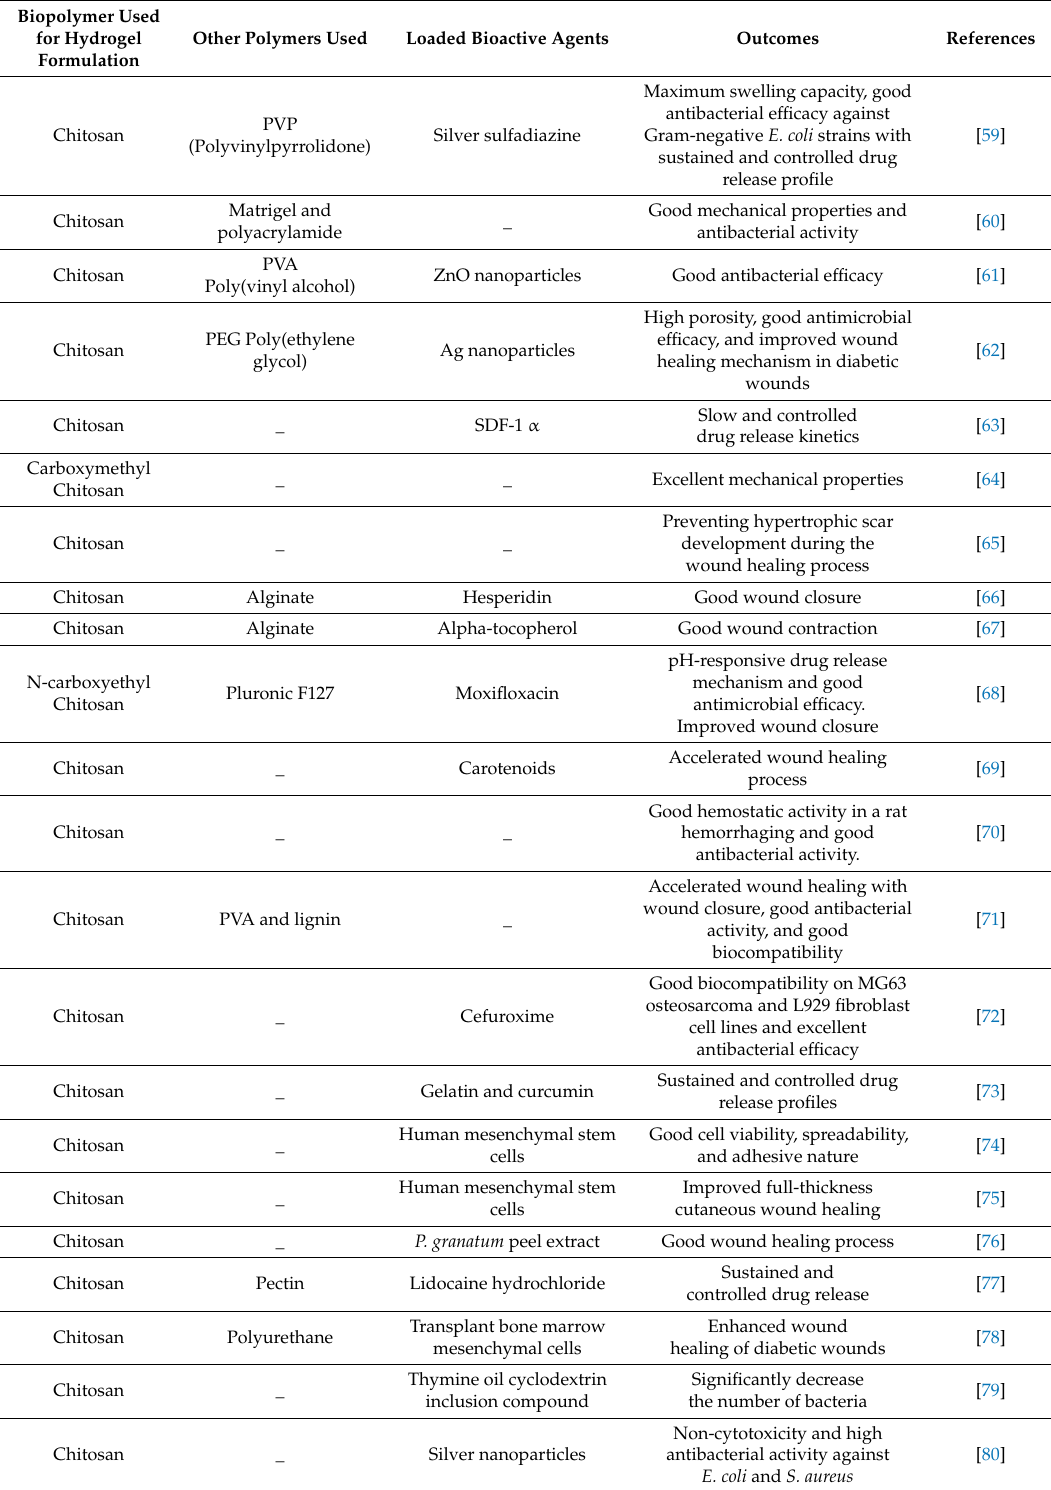
Table 1. Summary of hydrogels that are formulated from chitosan and